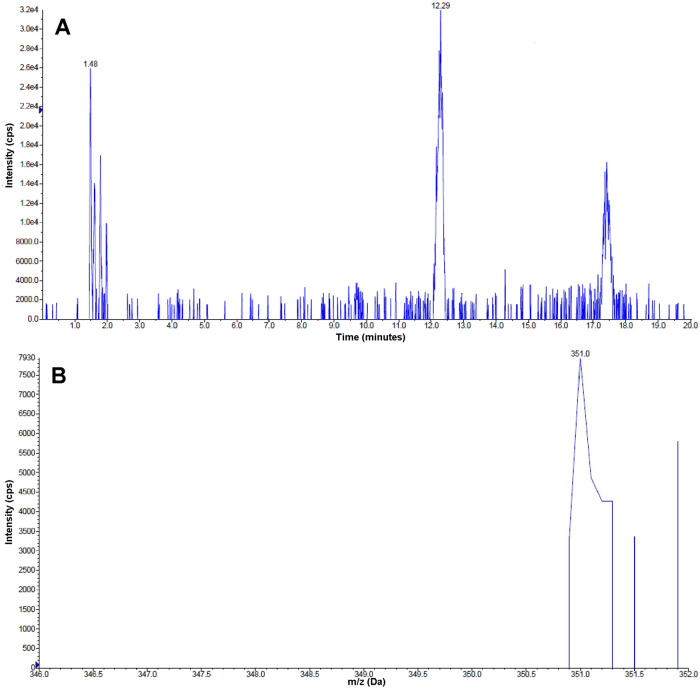
Identification of AFB1 dialcohol by HPLC-MS.(A) Chromatogram of the purified AFB1 dialcohol product obtained from the reduction of AFB1 dialdehyde with NaBH4. The peak at tR = 12.29 shows the putative AFB1 dialcohol product. (B) Protonated monoisotopic mass found in the 12.29 min peak, corresponding to a value of 351.0 Da.